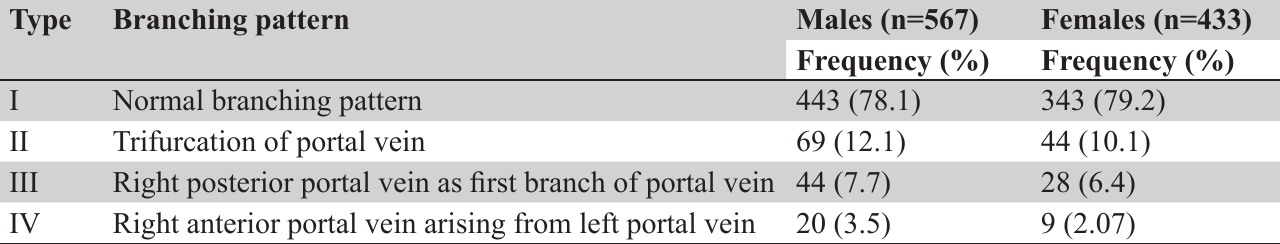
Table 2. Branching pattern of the portal vein in relation to sex (N=1000).